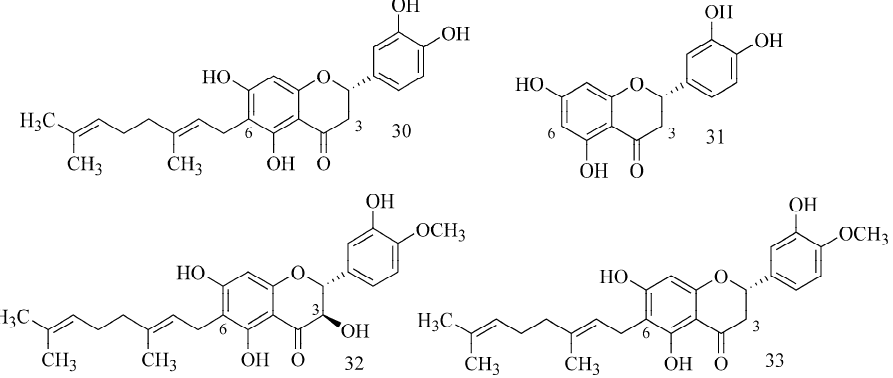
Figure 11. Chemical structures of diplacone ( 30 ), eriodictyol ( 31 ) , 4 ′ -O-methyldiplacol ( 32 ) and 4 ′ -O-methyldiplacone ( 33 ).